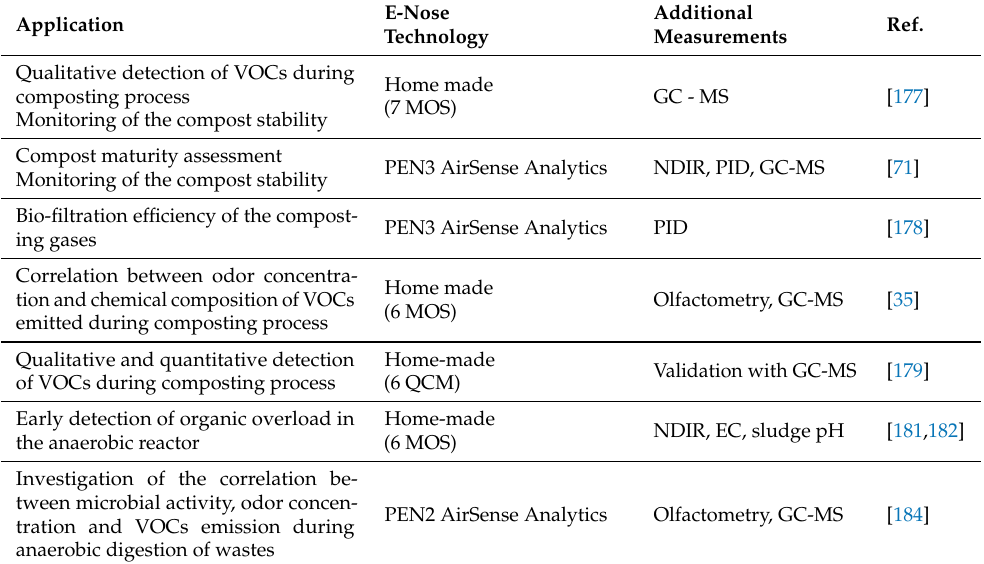
Table 7. Examples of analytical e-noses applications in the waste management